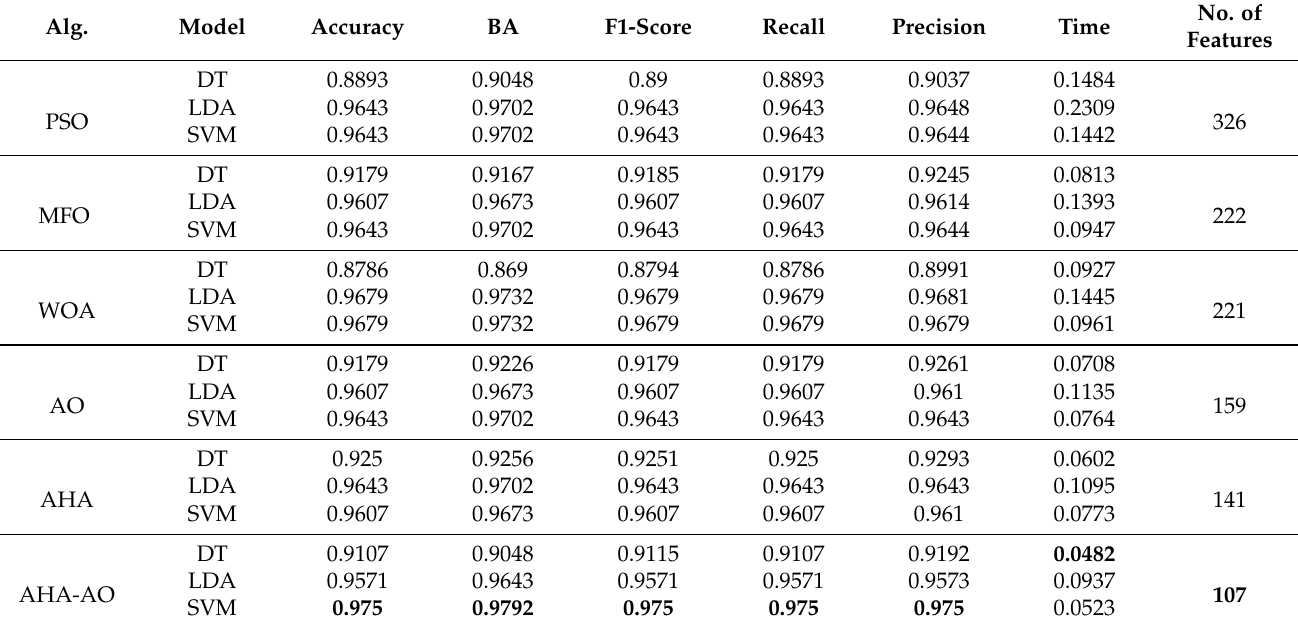
Table 5. Classification results of each feature selection optimization algorithm on the PH2 dataset (bold refers to best